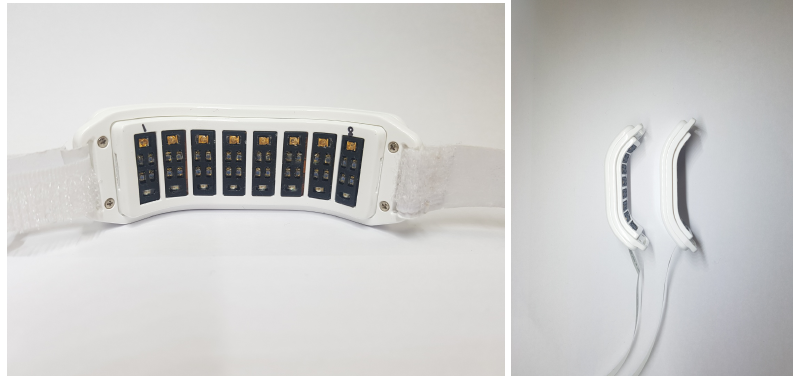
Figure 8. The optimized wrist surface type band by firmly attaching the PD array onto the wrist ( Left panel ). An examples of two bands with different curvatures optimized for: participants with small wrist (left in the right panel ) and participants with normal or thick wrists (right in the right panel